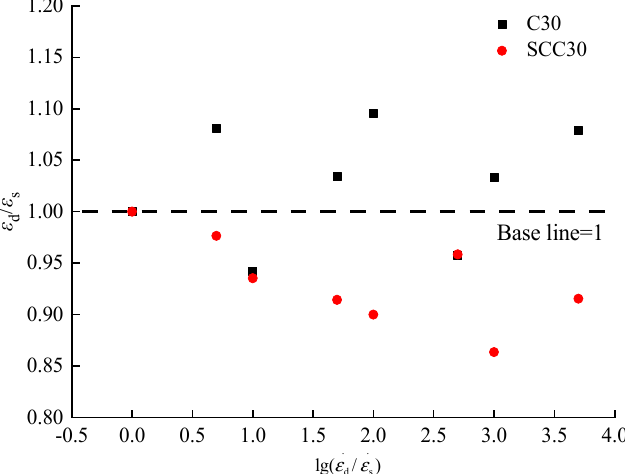
Figure 13. Relationship between strain rate and variation factor of peak strain.